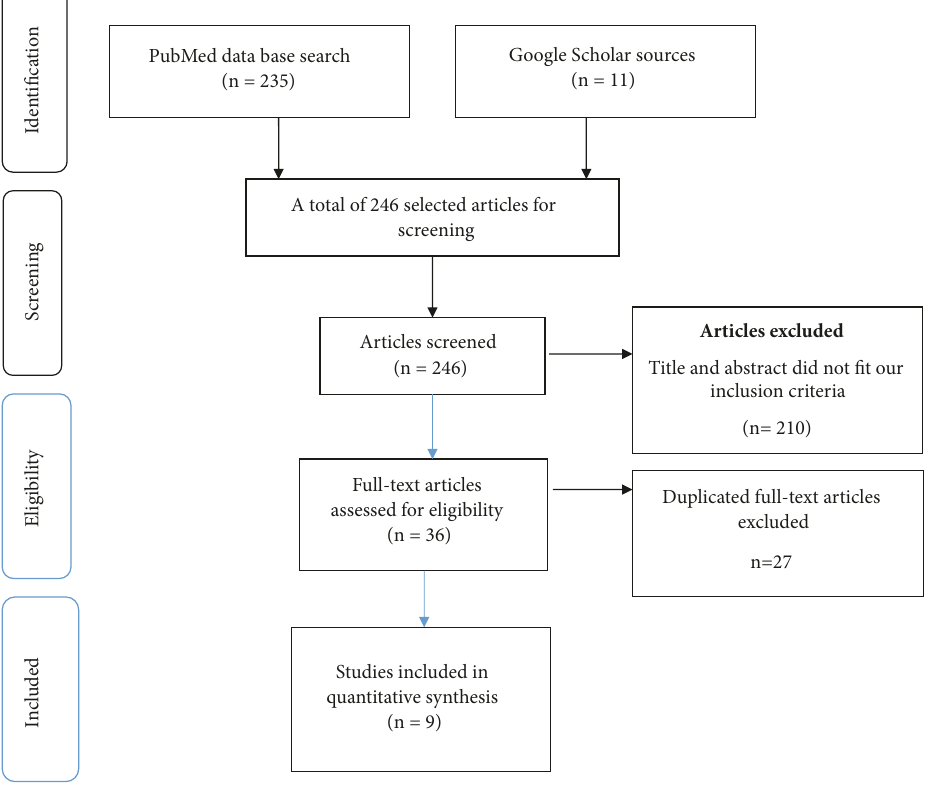
Figure 1: Flow chart of study